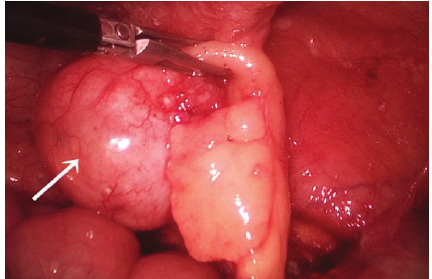
Figure 11: Swelling at the distal part of the appendix, white arrow- laparoscopic view (second case).